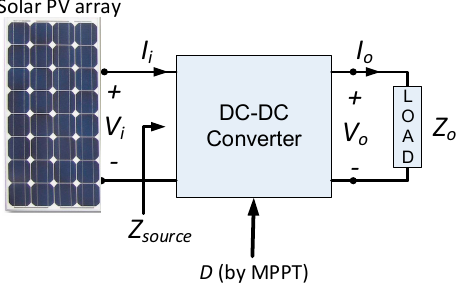
Figure 2. Block illustration of general MPPT operation [15].